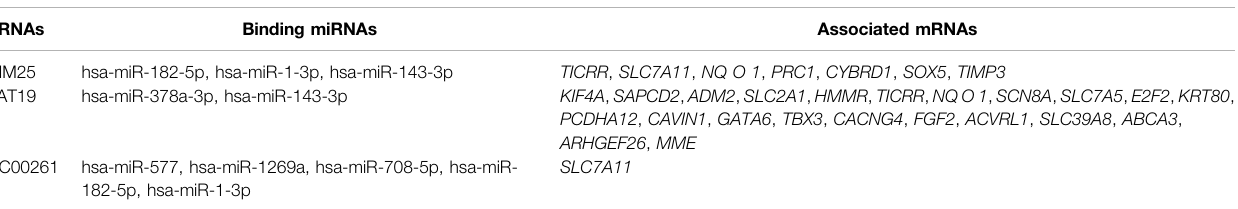
TABLE 3 | Key lncRNAs, miRNAs, and mRNAs in the ceRNA network of lung adenocarcinoma. lncRNAs